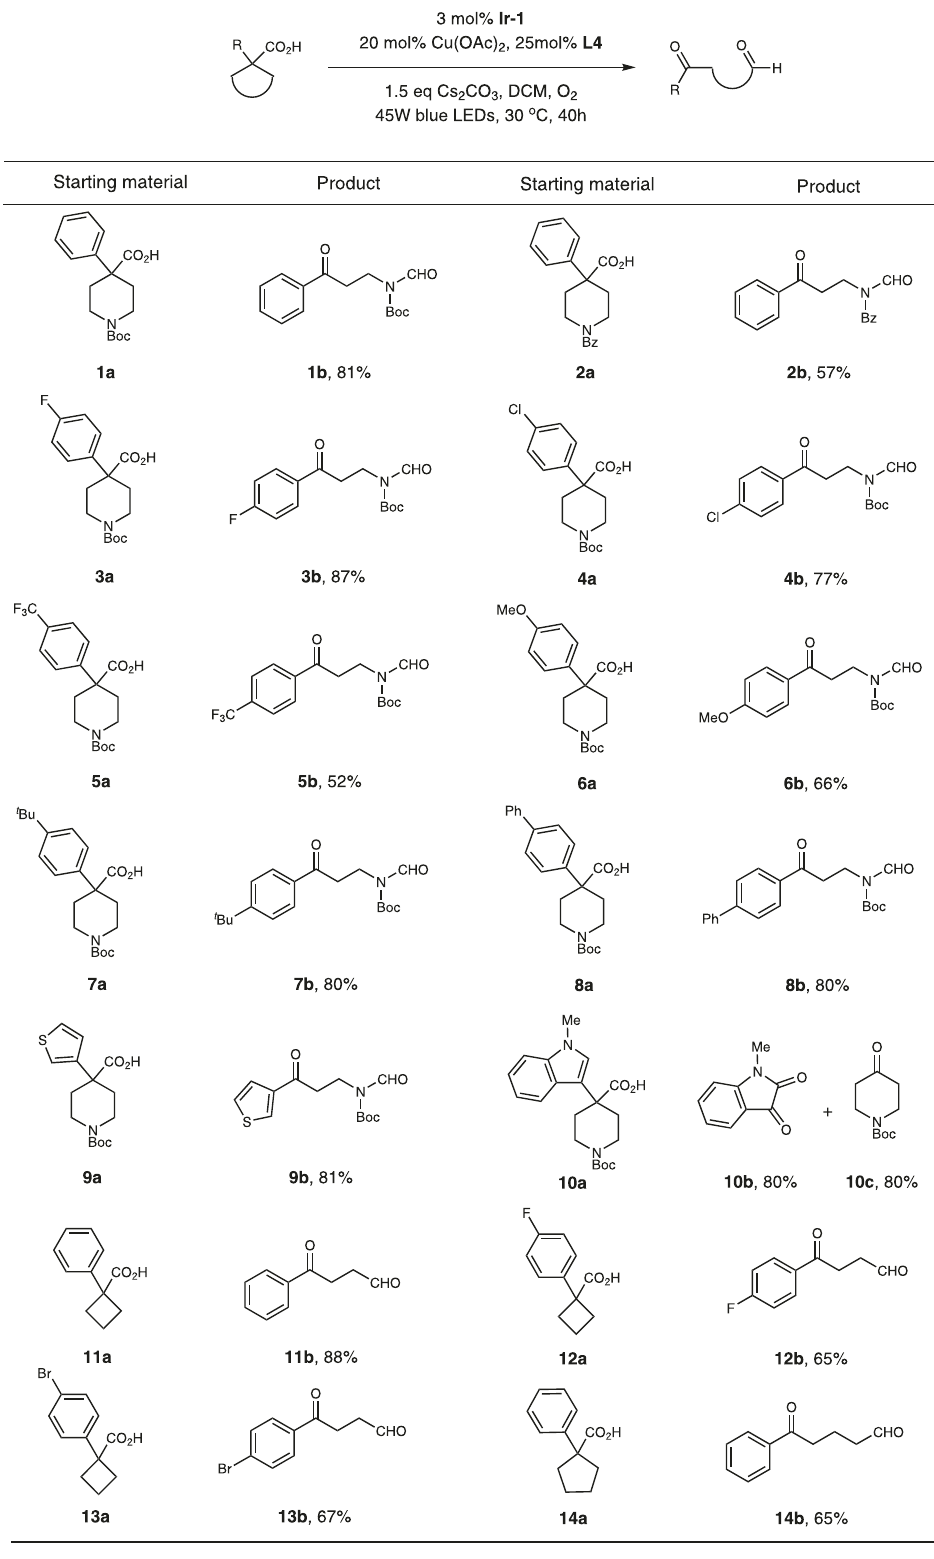
Fig. 2 | Substrate scope of aromatic substituted cyclic acids. Reaction conditions: substrate (0.5mmol), Ir-1 (0.015mmol), Cu(OAc) 2 (0.1mmol), L4 (0.125mmol), Cs 2 CO 3 (0.75mmol), DCM (10mL), 45W blue LEDs, 30°C, 40h.